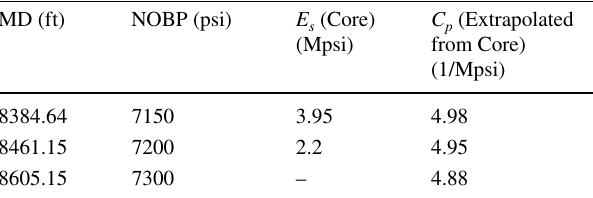
Table 3 Geomechanical core measurements, including static